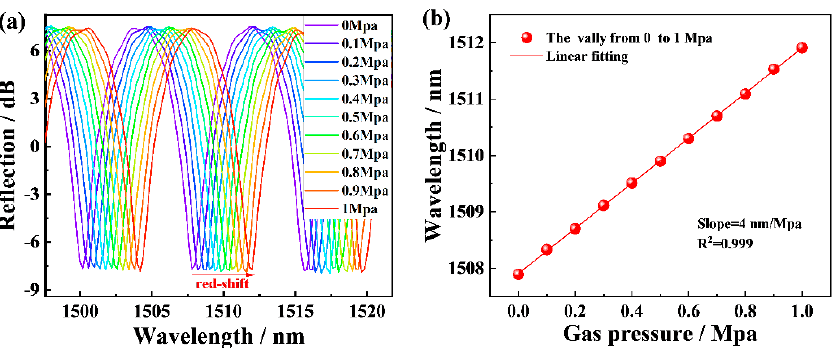
Figure 3. Pressure response of single sensing cavity. ( a ) Reflection spectrum. ( b ) Linear fitting.